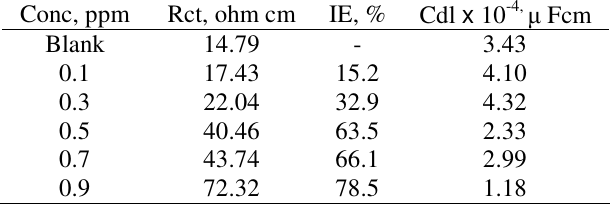
Table 5. Electrochemical and Impedance parameters of MS in the presence of